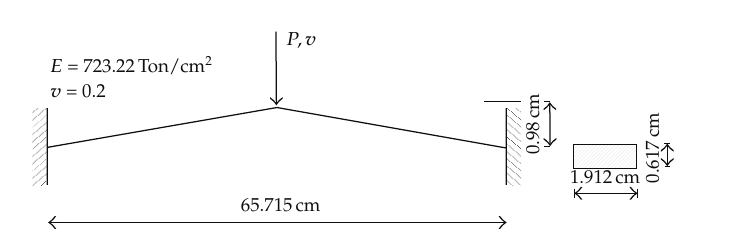
Figure 2: Williams toggle